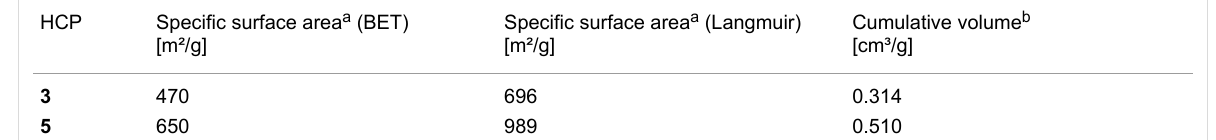
Table 2: Data of adsorption measurements of HCPs 3 and 5 .